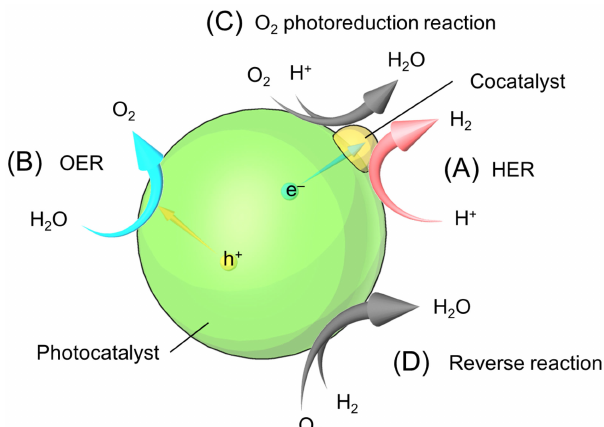
Figure 28. Possible reactions that occur over a water-splitting photocatalyst during the photocatalytic reaction: (A) HER, (B) OER, (C) O 2 photoreduction reaction, and (D) reverse reaction